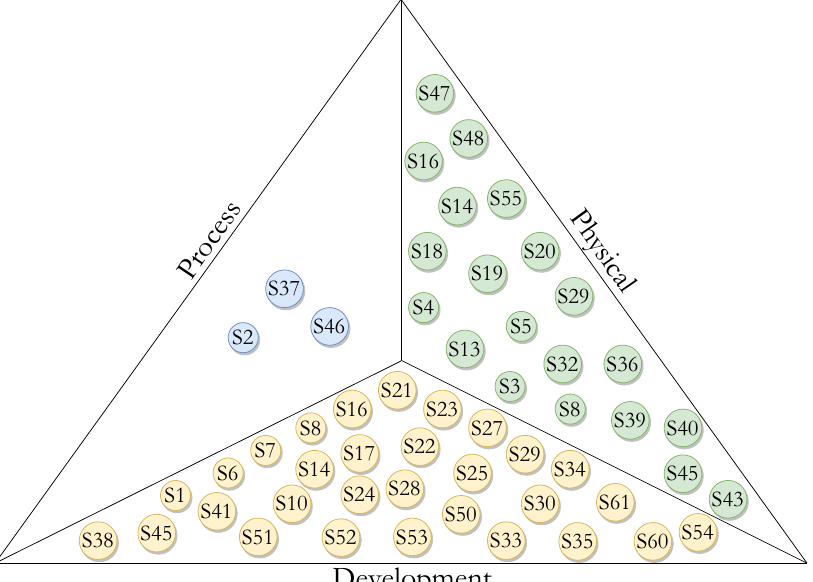
Figure 4. Distribution of primary studies concerning facilitators. Blue circles correspond to process, green to physical, and yellow to